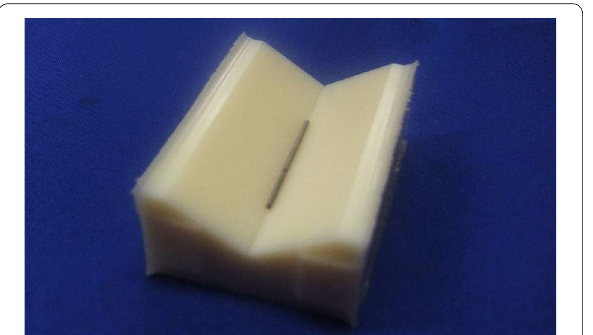
Fig. 7 Developed V-shaped aligning sub-device